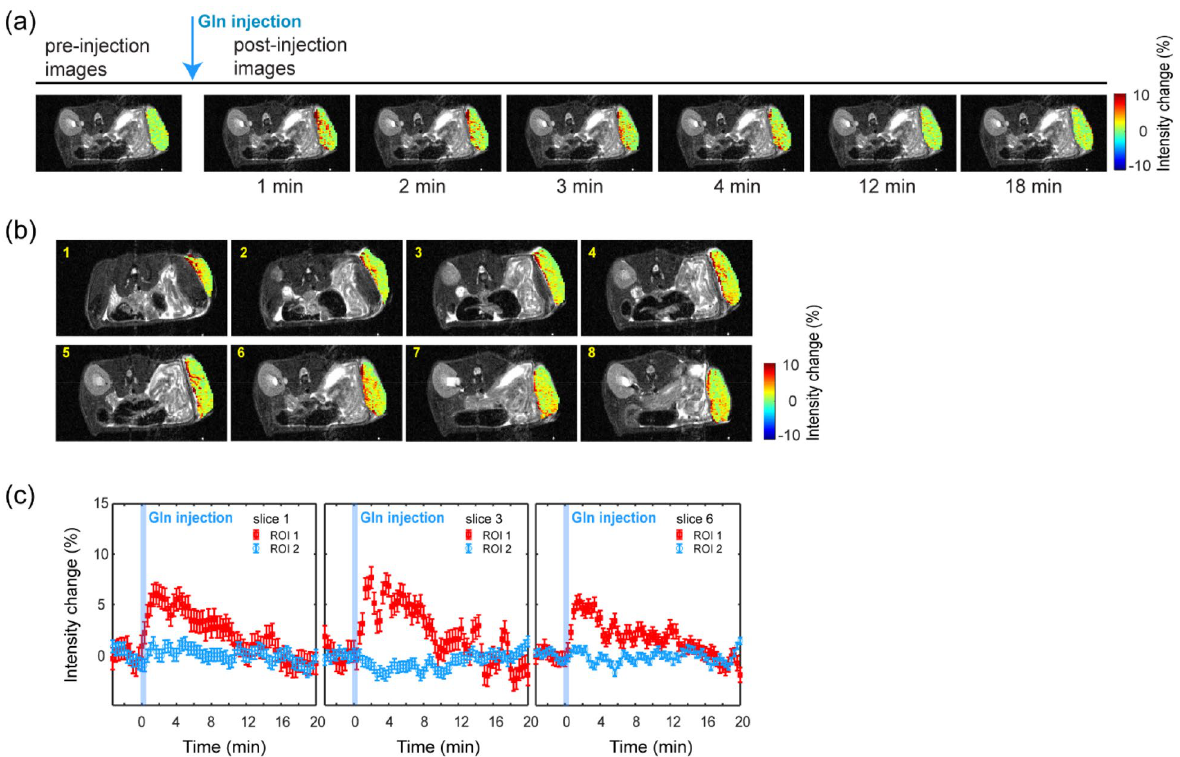
Figure 2. Images of glutamine uptake in the mouse xenograft model using HT29 cells. Only the intensity change in the tumor region is displayed. ( a ) Dynamic images from a single slice over time. ( b ) Representative images from serial slices of a single animal. The average of the intensity change over the first 4 min post injection is displayed. The slice number is indicated on the images. ( c ) Time-dependent intensity changes of T 2 weighted images from the selected slices. Glutamine injection is indicated in blue. The time-dependent profiles are displayed for the regions of strong (ROI 1, indicated in red) and weak (ROI 2, indicated in blue) glutamine